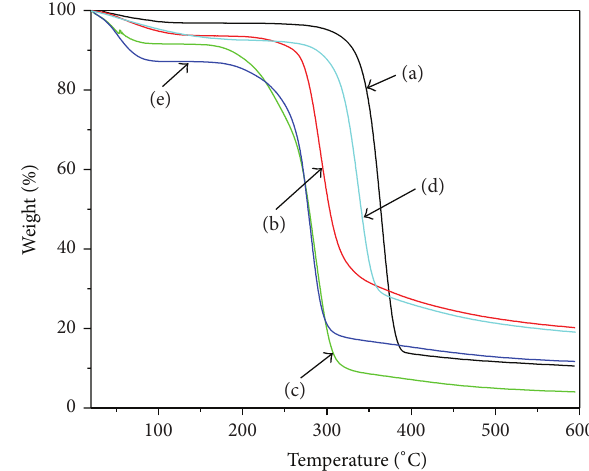
Figure 3: XRD images of films, (a) cotton linter, (b) AmimCl, (c) BmimICl, (d) EmimCl, and (e) EmimAc.